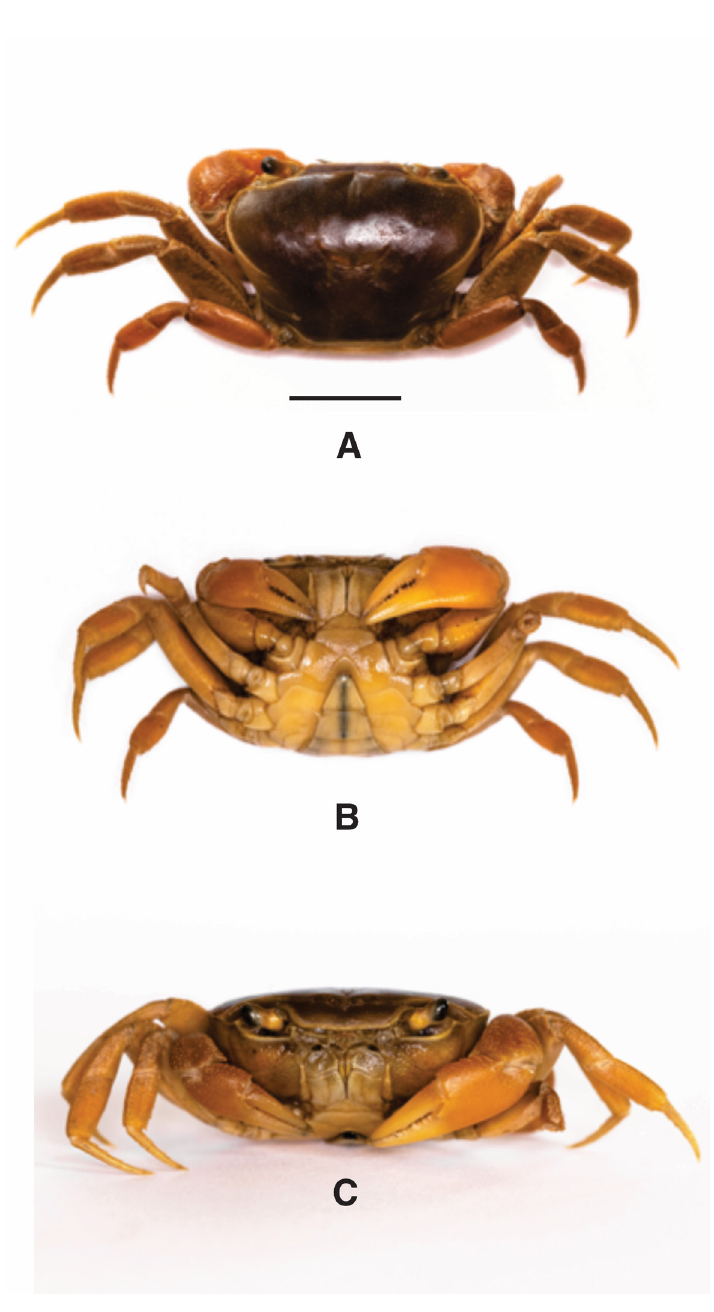
Fig. 2. Potamonautes mariepskoppie sp. nov., ♂, holotype (CL = 19.07 mm) (SAM A-094471). A . Entire animal, dorsal aspect. B . Entire animal, ventral aspect. C . Cephalothorax, frontal aspect. Scale bar = 10